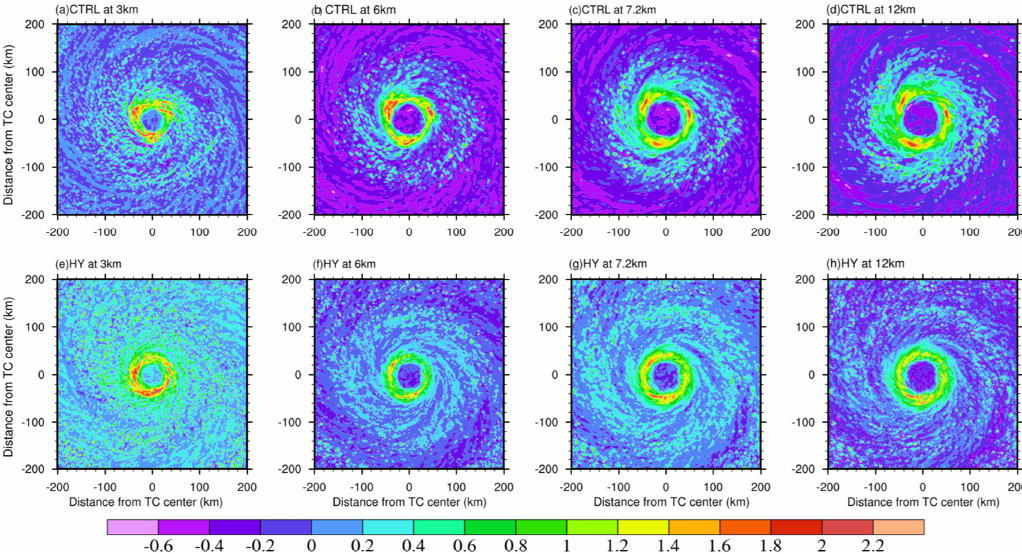
Figure 14. Horizontal distributions of the simulated vertical winds from 3 km to 15 km for ( a, b, c, d ) CTRL and ( e, f, g, h ) HY.